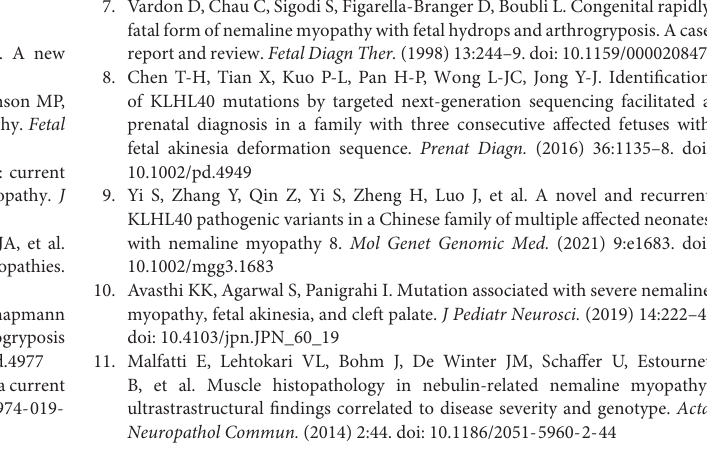
Supplementary Figure 1 | Variant identification by Sanger sequencing. The red arrow represented the variant site (c.1516A >